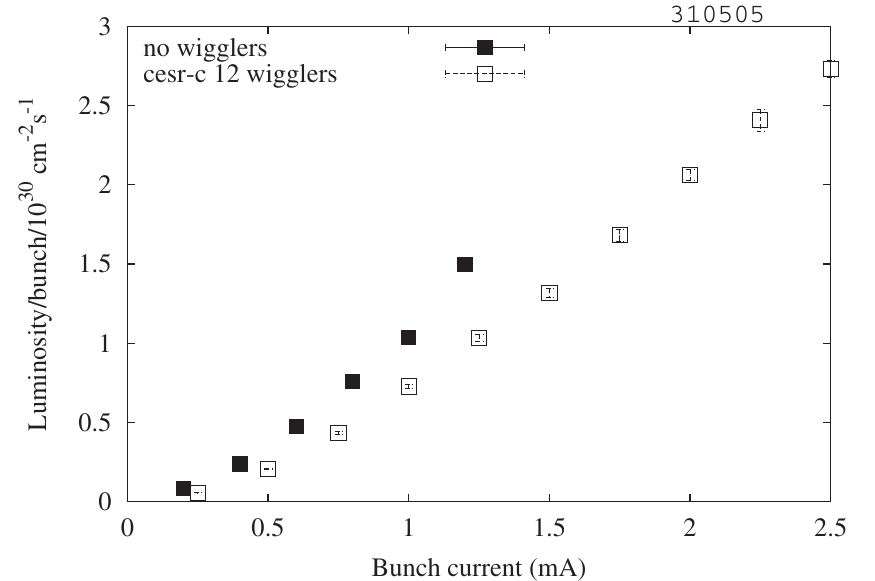
FIG. 17. Simulated luminosity for the 1 : 89 GeV = beam optics with no damping wigglers. The simulated luminosity data for standard CESR - c optics are plotted for